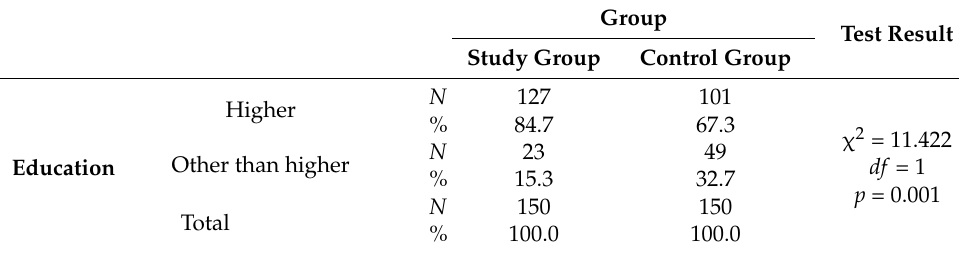
Table 2. Comparative characteristics of education of both the SG and the